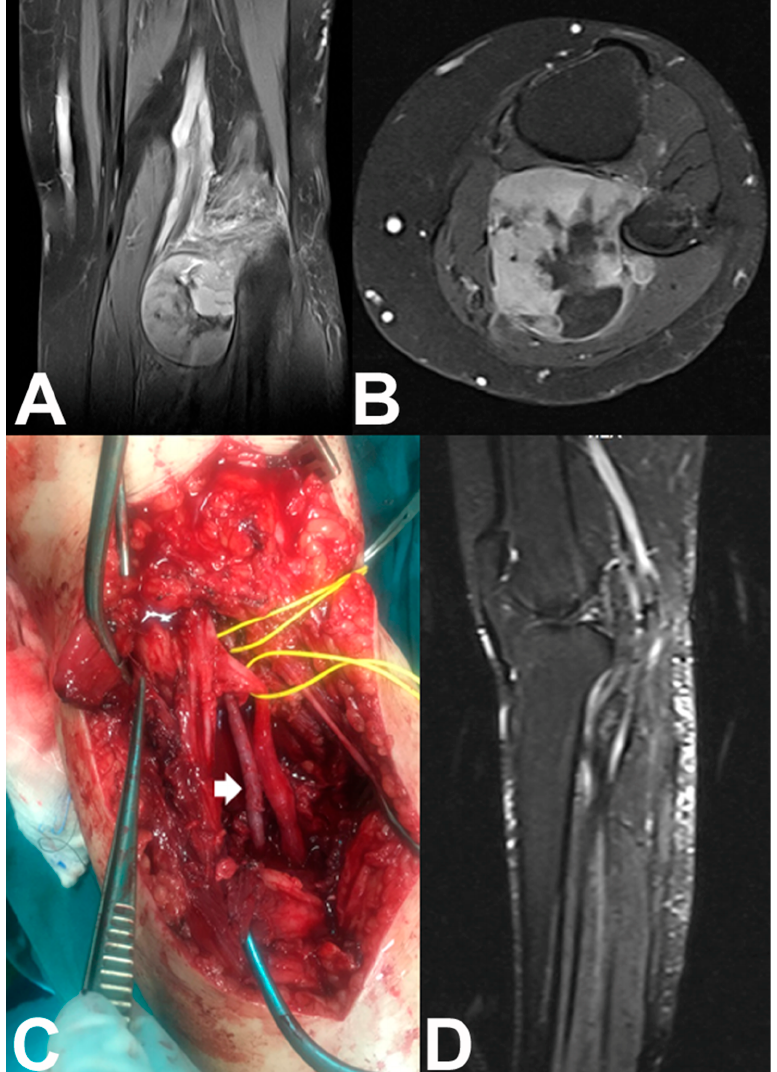
Figure 2. ( A ) Coronal and ( B ) axial T2-weighted MR images of the left knee of a 55-year-old woman with a popliteal fossa synovial sarcoma. ( C ) En bloc (marginal) tumor resection was done after identification and preservation of the peroneal and tibial nerves (lower vessel-loop), ligation without reconstruction of the popliteal vein, identification of the popliteal artery (upper vessel-loop), and arterial bypass reconstruction with the tibial artery using a contralateral great saphenous vein graft (white arrow) without venous bypass reconstruction. ( D ) Sagittal T2-weighted MR image shows tumor resection and limb preservation with patent anastomosis.